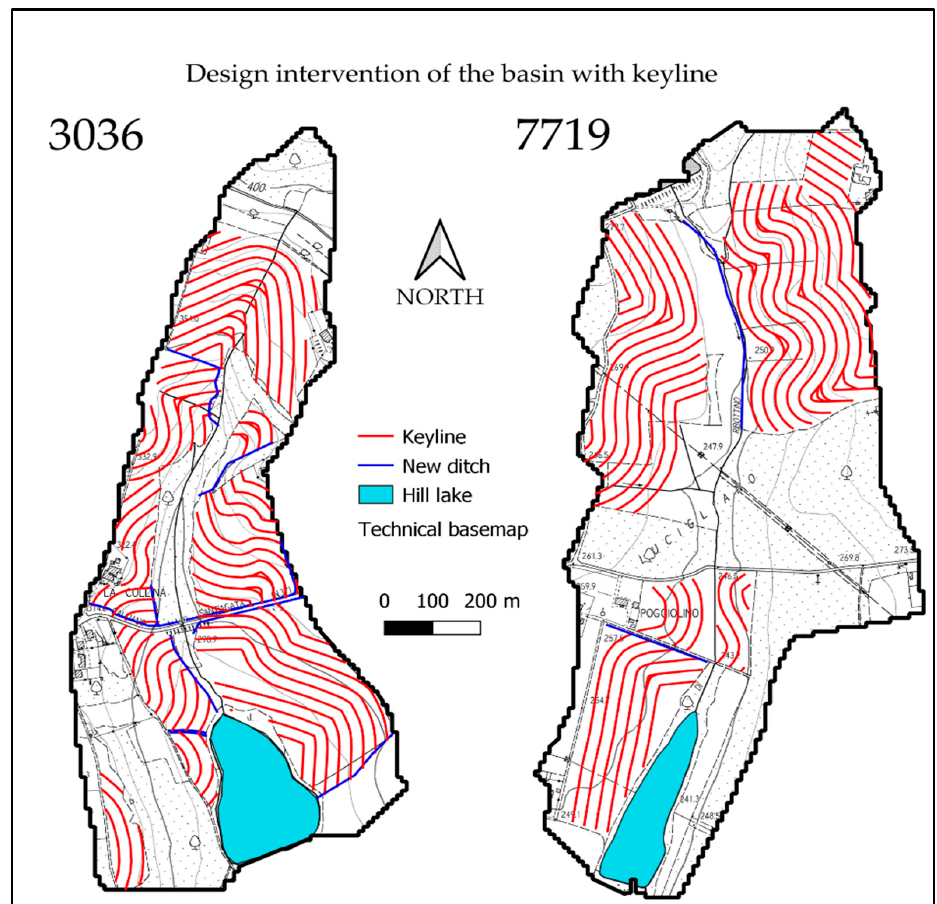
Figure 3. Arrangement of keylines in arable land.